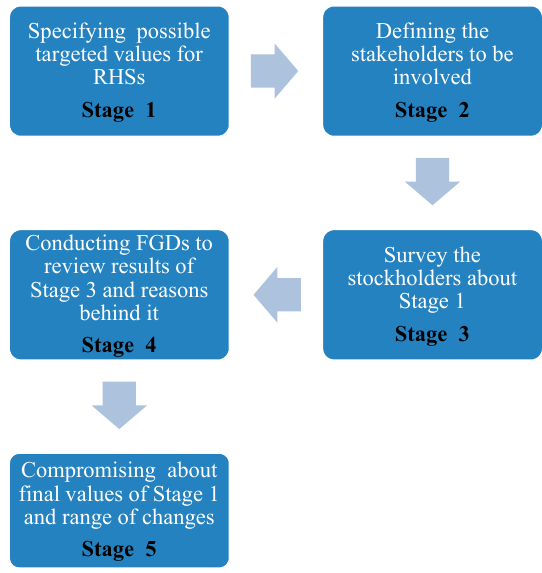
Figure 2. Distribution of nodes and candidate Primary Health Care Centers (PHCCs) for the relevant location-allocation problem.